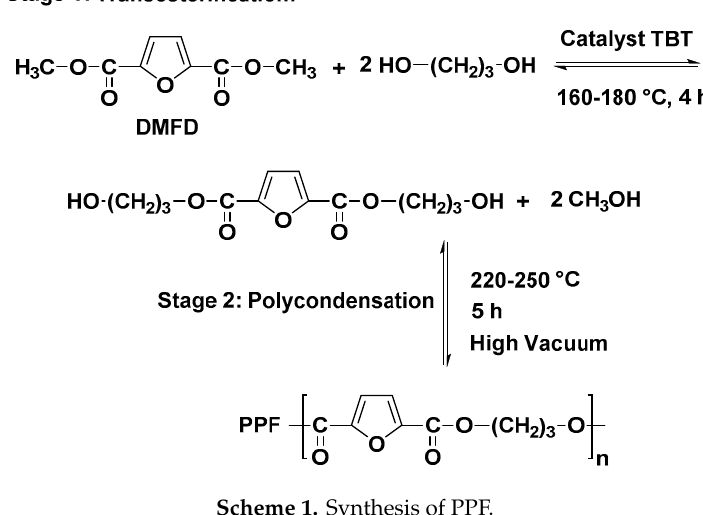
Scheme 1. Synthesis of PPF.